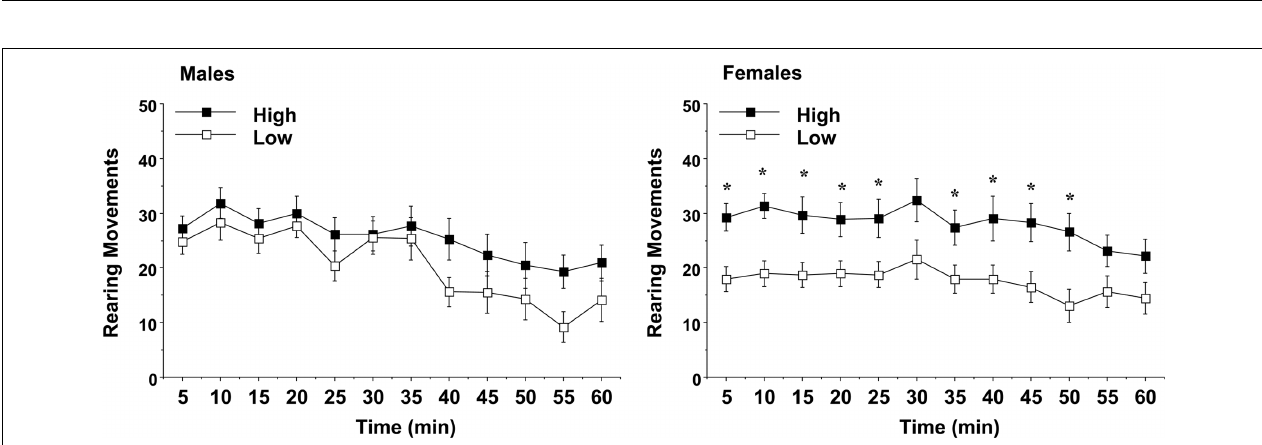
FIGURE 6 |Vertical activity in a novel environment during a 1-h session. Data shown are means ( ± SEM) for the first (Day 1) test. Female offspring of